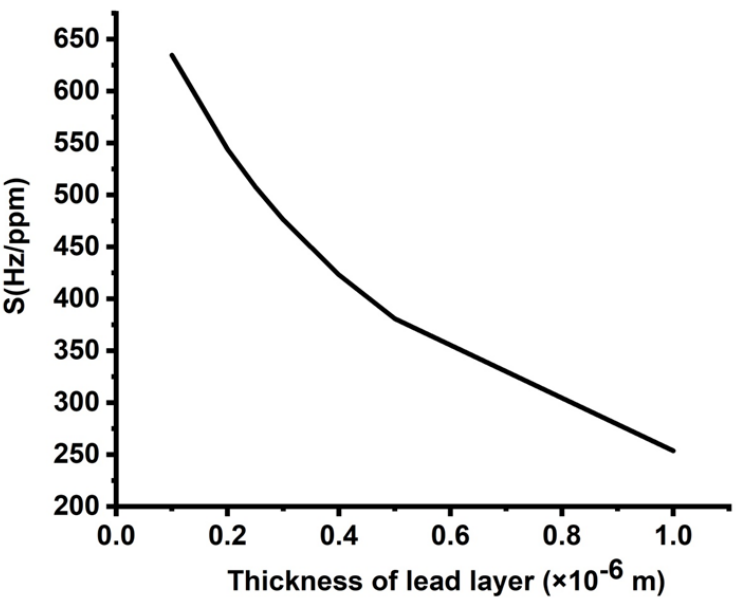
Figure 5. Sensitivity of the designed sensor at different thicknesses of lead layers.